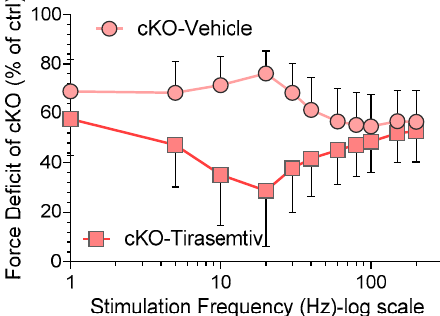
Figure 3. Tirasemtiv reduces the force deficit of cKO diaphragm strips. Specific force of cKO in vehicle (circles) or tirasemtiv (squares) relative to ctrl (in vehicle). A standard two-way ANOVA reveals that tirasemtiv has a significant ( p < 0.0001) effect on the force deficit. Post-hoc tests (Sidak) corrected for multiple comparisons reveal that tirasemtiv significantly reduces the force deficit of cKO diaphragm at all stimulation frequencies up to 100 Hz ( p < 0.001) with the largest effect at intermediate stimulation frequencies (e.g., at 20 Hz the deficit goes from 76% to 29%). Mean ± SD are shown. Load-clamp experiments were performed in which the diaphragm was tetanized at a 50 Hz stimulation frequency (this frequency was selected because it is the lowest stimulation frequency that force was maximal, the force was abruptly decreased and held constant at a preset value, allowing